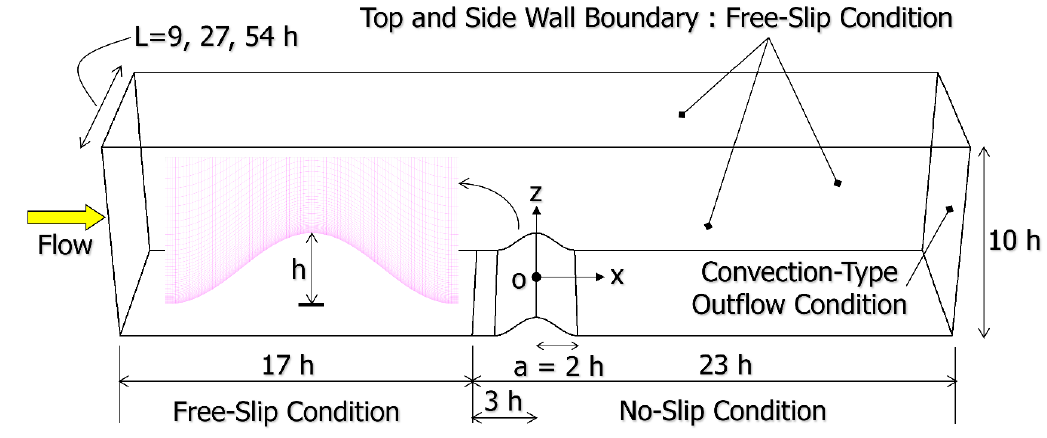
Figure 4. Computational domain, coordinate system, and boundary conditions.